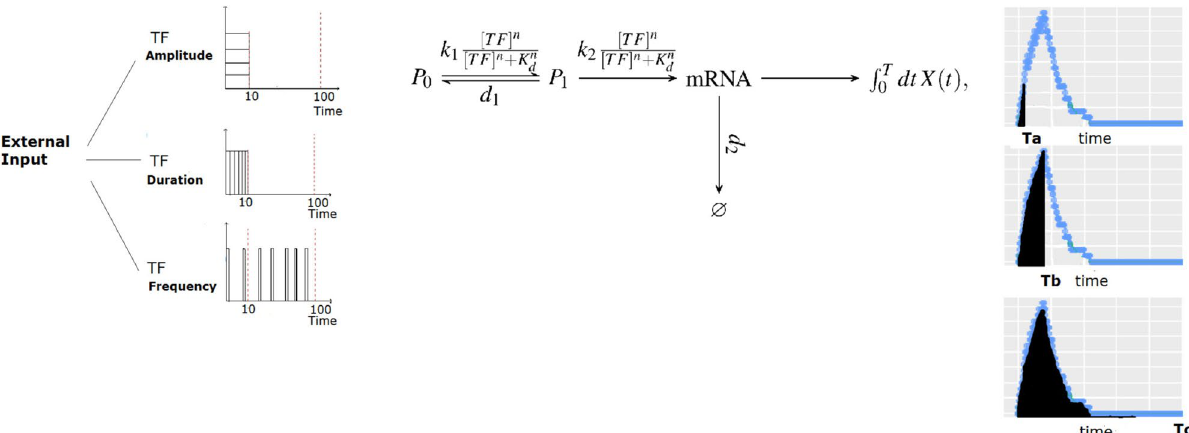
Figure 1. The model. An external stimulus is encoded in the (pulse) duration, (pulse) amplitude or (inter- pulse) frequency of the nuclear TF concentration, [ TF ]. The model does not describe this first step of the codification process, but starts directly with the nuclear TF time course. Mutual information, MI , between input (pulse duration, pulse amplitude or mean inter-pulse frequency, depending on the type of stimulus codification or “ TF modulation type”; 3 subfigures on the left) and output (the time integral of the number of mRNA molecules produced, X ) is computed choosing three possible time cuts for its calculation (3 subfigures on the right which correspond to an example with a single TF pulse of amplitude, 100, and 10 min duration). In between, converting input into output, is the transcription model 24 described in more detail in the main body of the